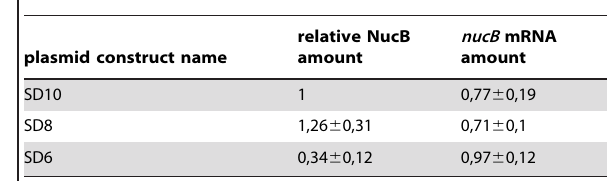
Table 4. Relative hMGFP protein level in E. coli TOP10 harboring pUC19 constructs containing start codon upstream sequences in which SD sequences form part of a secondary structures with different stabilities.